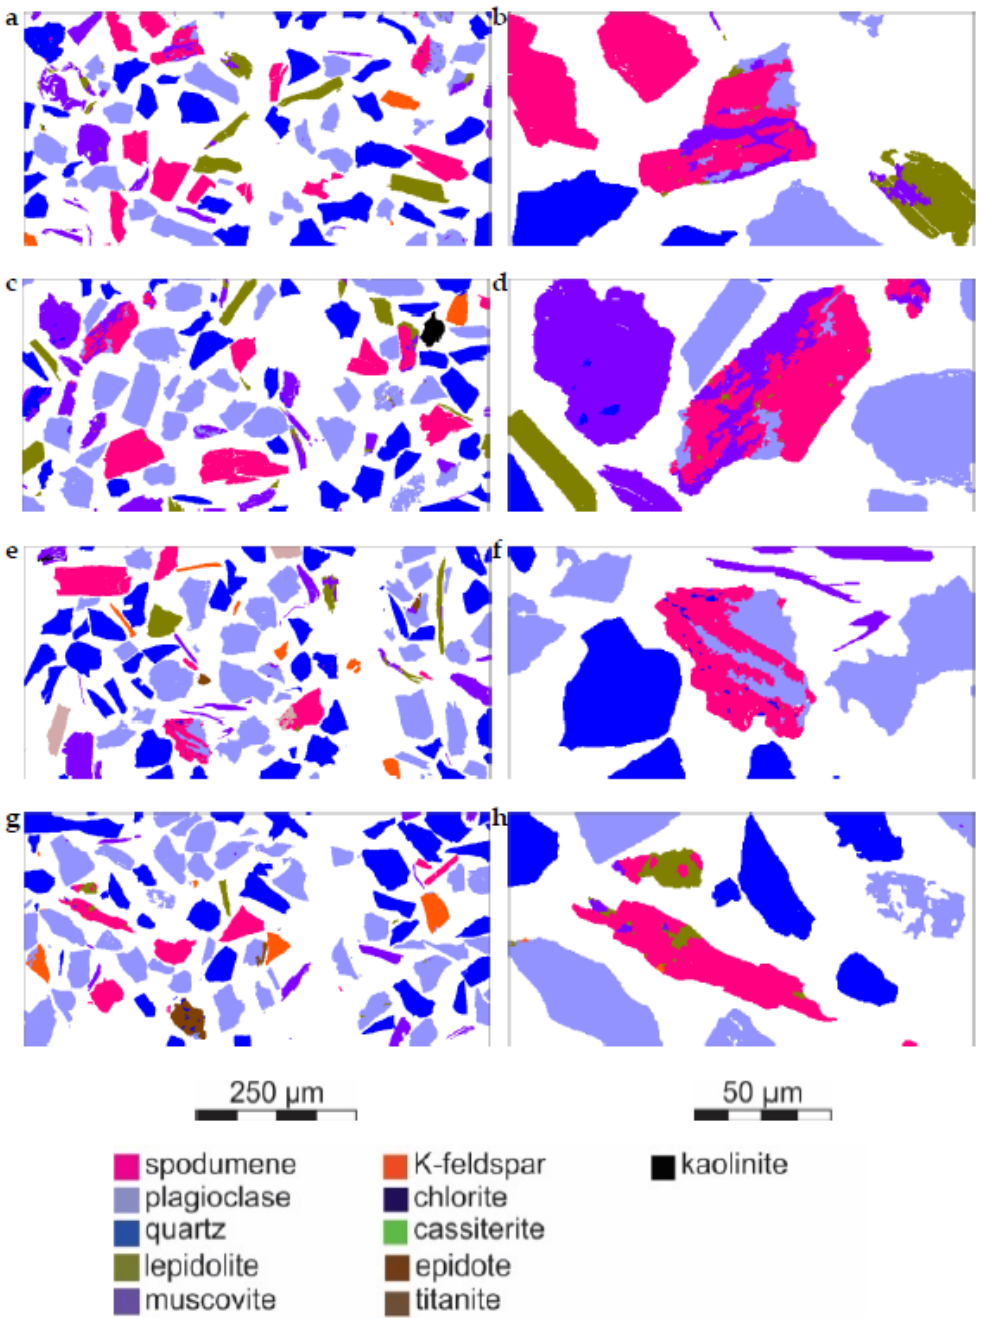
Figure 7. MLA mineral composition maps highlighting liberated spodumene and gangue mineral grains in the − 0.21 + 0.15 mm size fraction for G1 ( a , c ) and G2 ( e , g ). The mineral maps on the right size show an enlarged view of the different mineral textures in some spodumene grains from G1 ( b , d ) and G2 ( f , h ).